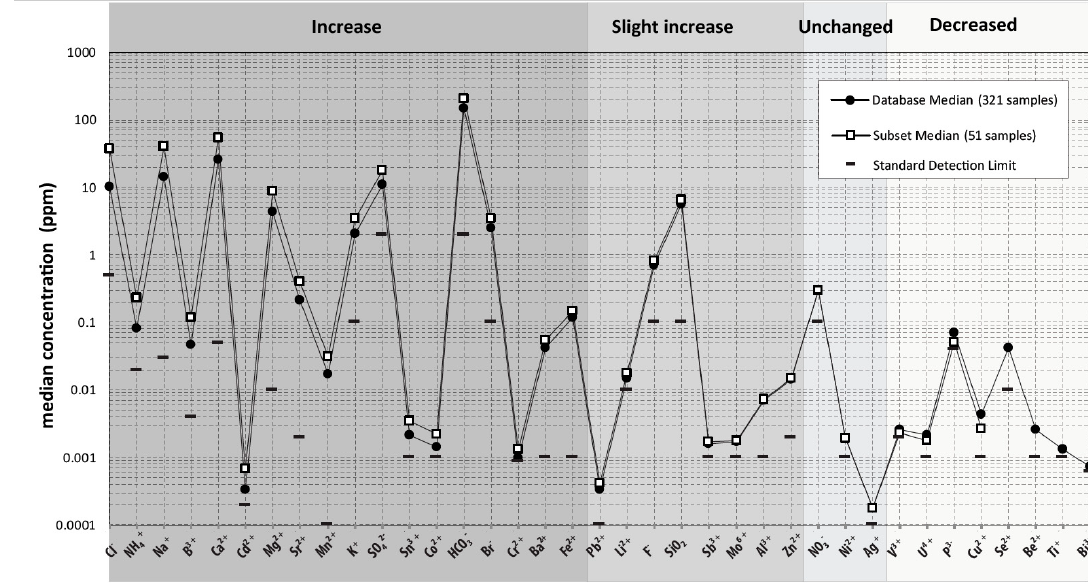
Figure 6. Comparison between the median concentration in ppm for each chemical element of the database and the subset on a log scale (y-axis). Chemical elements (x-axis) are sorted in descending order of differences between median concentrations for the 321 sample database and the 51 sample subset. Compared to the 321 sample dataset, the ionic content of the 51 sample subset increased, although the m.c. of some chemical elements remained unchanged or decreased. Variations for the medians of the 2 datasets calculated in percentage are presented in the Supplementary Materials S2).